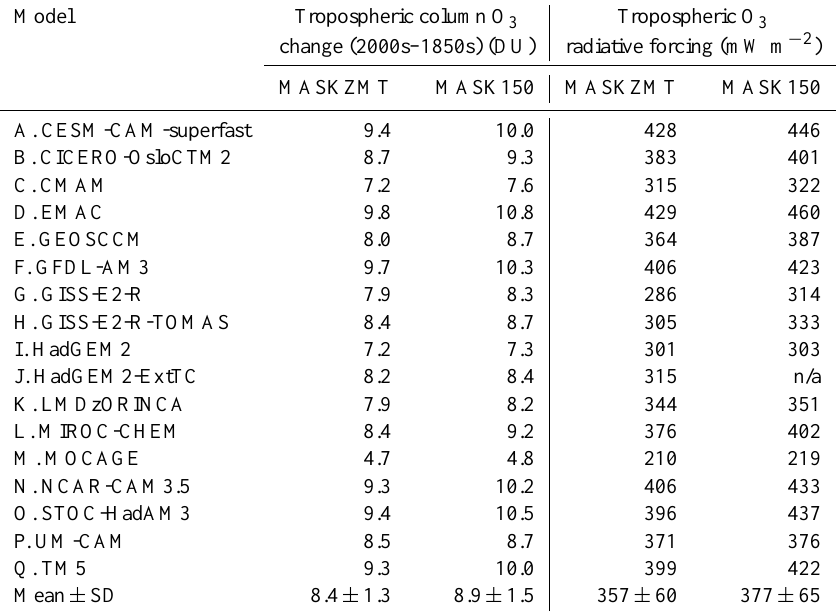
Table 3. Changes in tropospheric column ozone (DU) and radiative forcing (mW m − 2 ) for two different tropopause definitions (MASKZMT and MASK150). The mean and standard deviation (SD) excludes Model